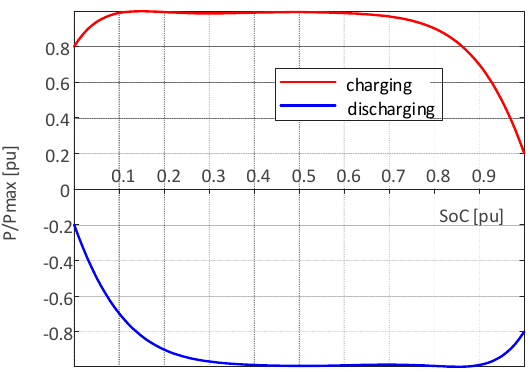
Figure 3. Dependence of charging and discharging power from the state of charge (SoC): Charging (positive-red) and discharging (negative-blue).